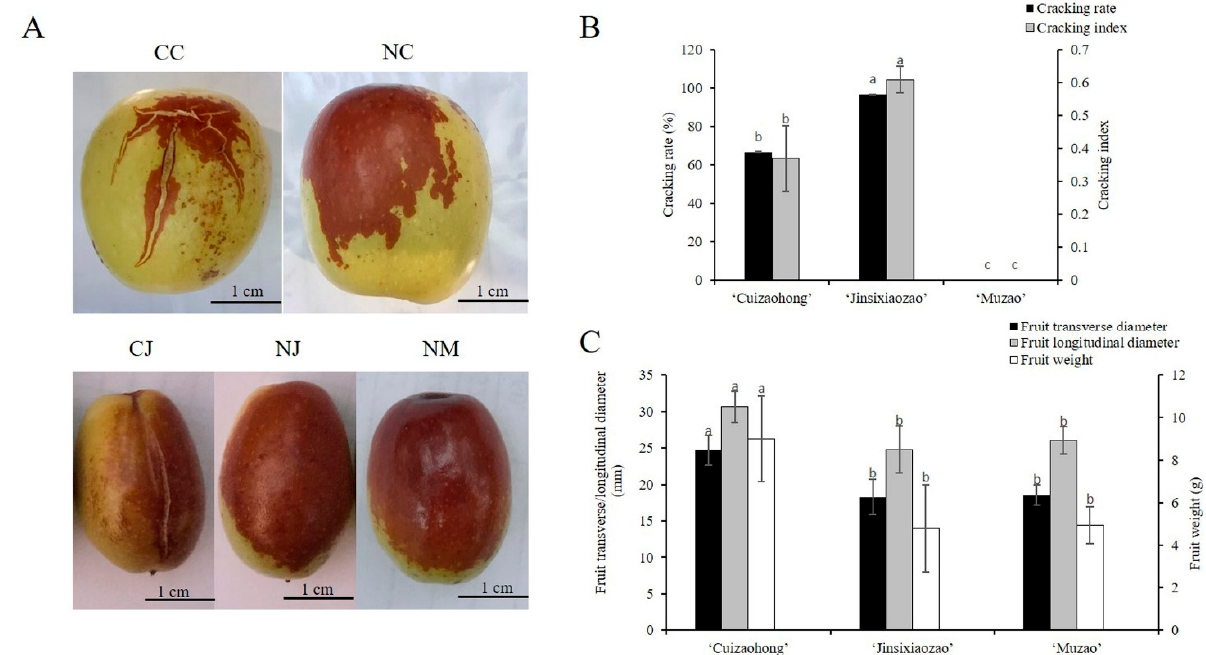
Figure 1. The phenotypes of the jujube at the half-red period ( A ) and evaluation of cracking resistance ( B ) and fruit size ( C ) of three jujube cultivars. CC: cracking ‘Cuizaohong’; NC: non-cracking ‘Cuizaohong’; CJ: cracking ‘Jinsixiaozao’; NJ: non-cracking ‘Jinsixiaozao’; NM: non-cracking ‘Muzao’, the same as below. Error bars represent standard errors from three biological replicates. Different lowercase letters indicate a significant difference between genotypes ( p < 0.05).